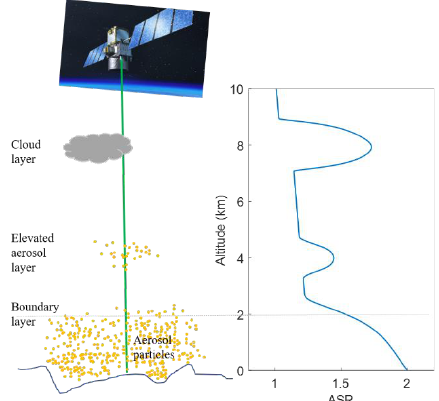
Figure 4. Diagram of ASR derived from CALIOP.